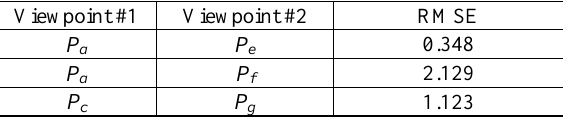
Table. 3, RMSE of candidate plane pairs